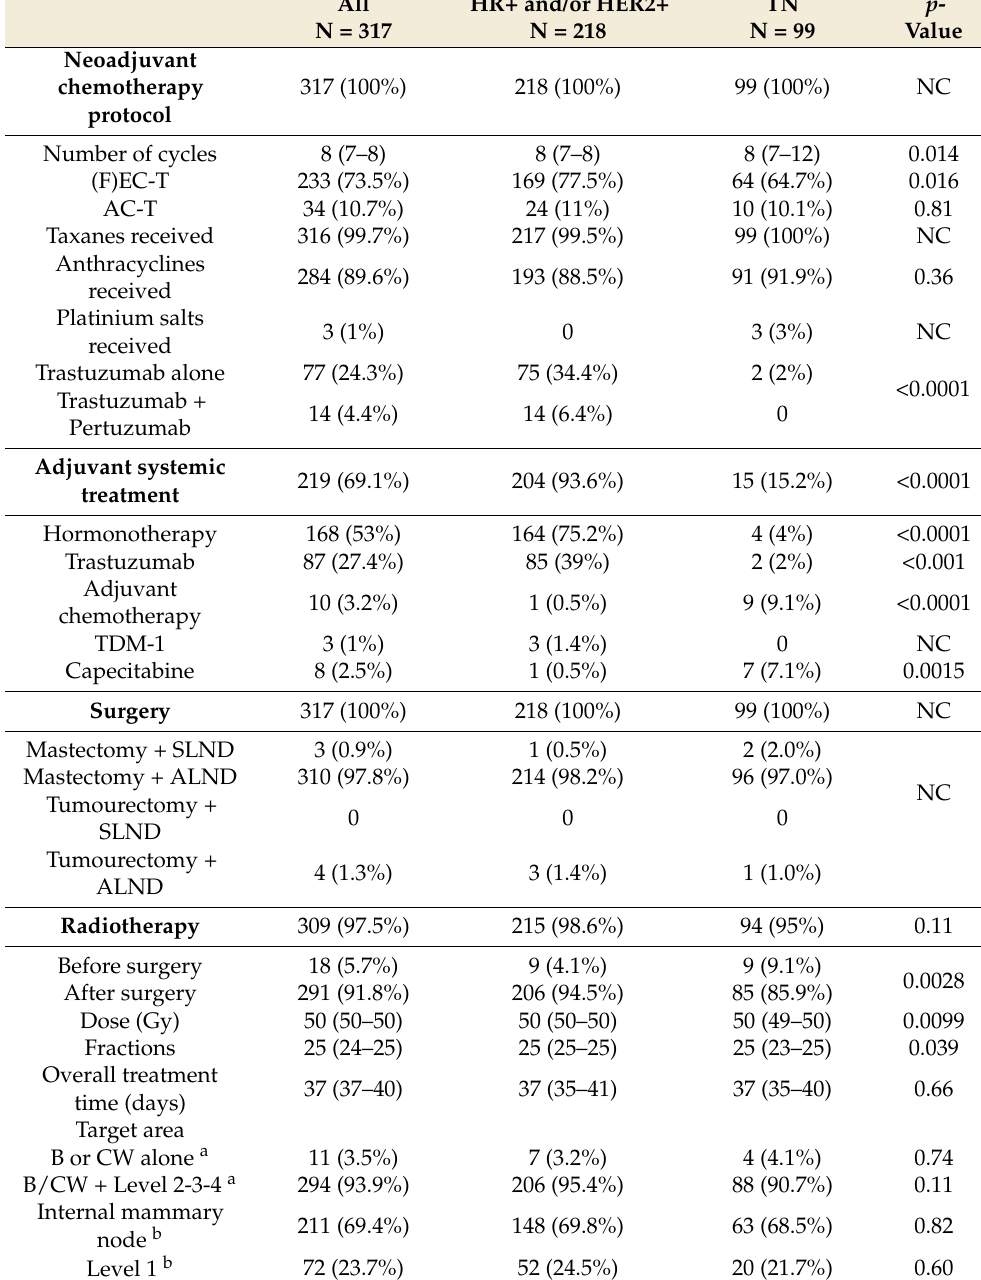
Table 2. Chemotherapy, surgery and radiotherapy